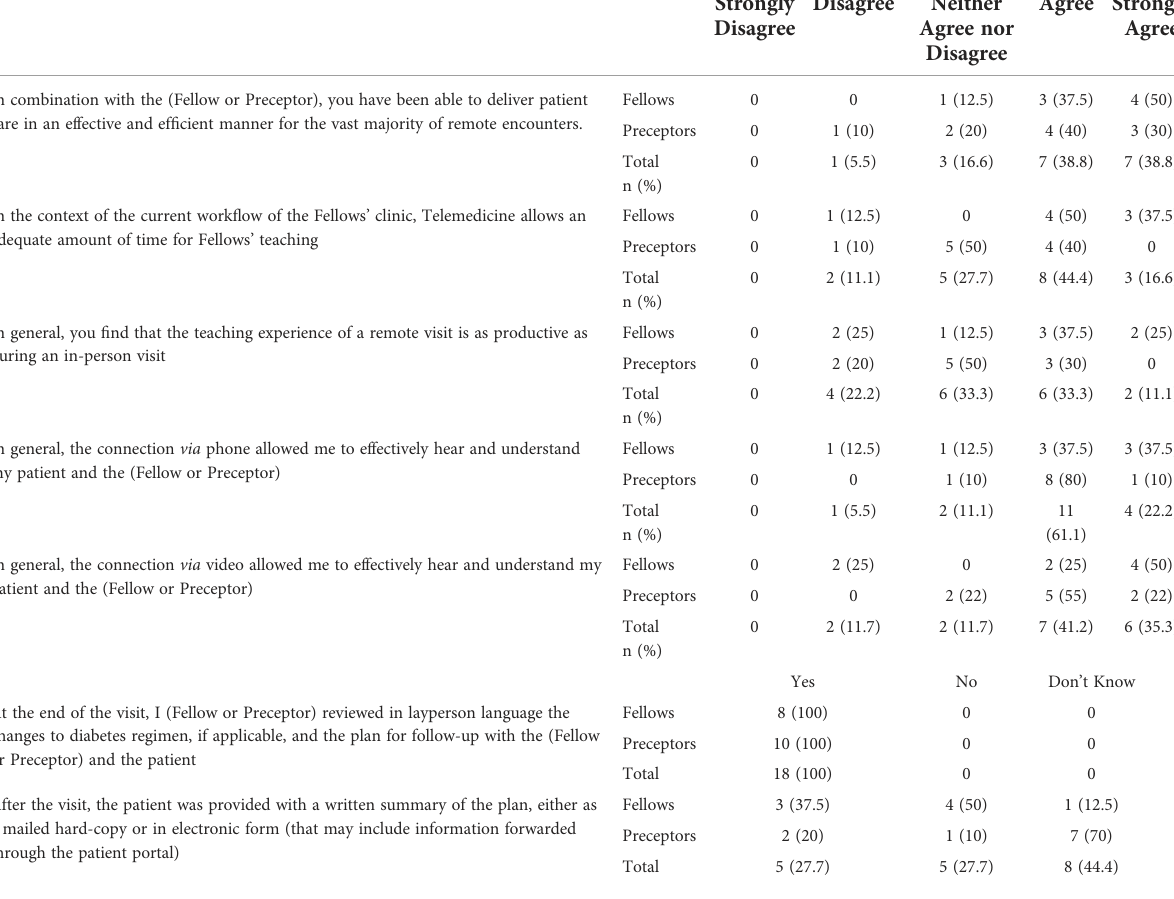
TABLE 3 Fellows and preceptors survey on remote visits within diabetes-focused teaching